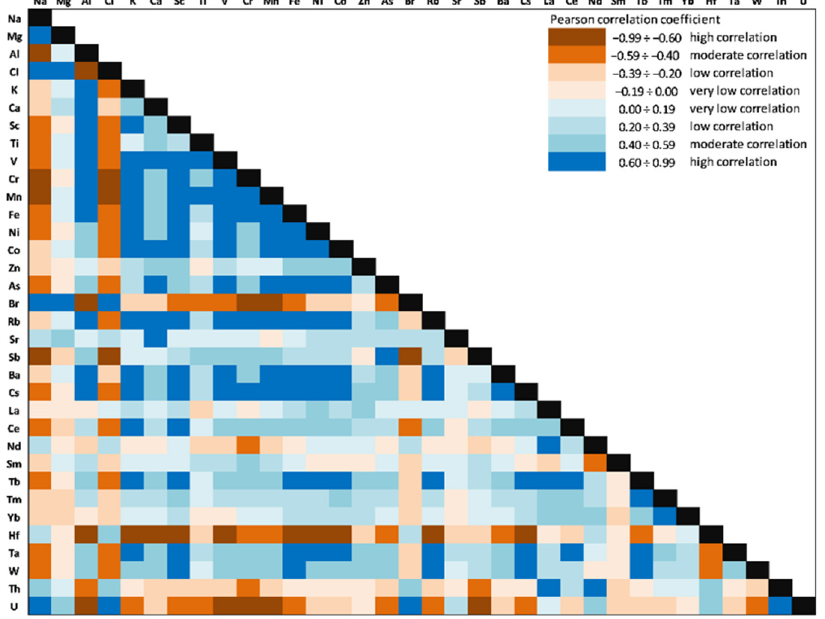
Figure 26. Pearson correlation map based on coefficient matrix for the relationship between the element concentrations in the Movila Miresii Lake sediment core.